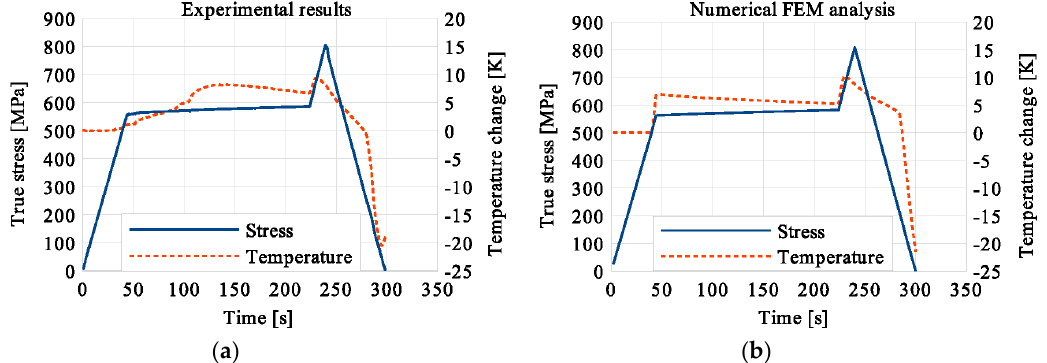
Figure 6. Stress and temperature variations vs. time for the loading program (1): 3-min loading interruption at the beginning of LMT: ( a ) experimental; ( b ) numerical results.